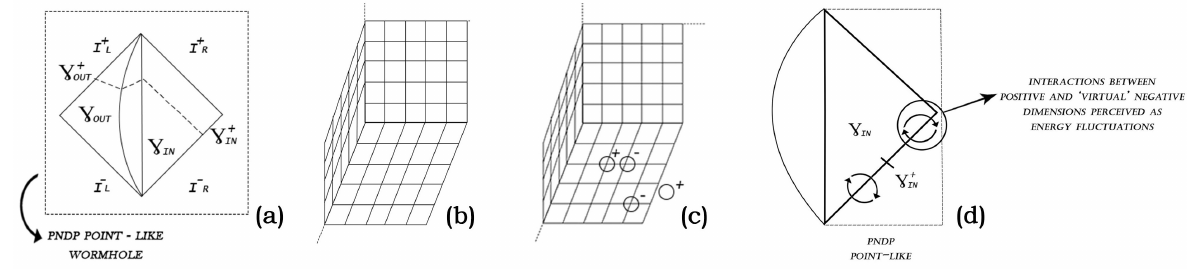
Figure 3. In ( a ), it was represented the ( 1 + 1 ) wormhole introduced and studied in Reference [27], in which we consider it created by a PNDP in a point-like version. The curve γ IN represents the entrance, while the curve γ OUT represents the exit. In ( b ), a vacuum place in space-time is represented. In ( c ), pairs of virtual particles are represented, particle-anti particle that annihilate. So, ( b , c ) represent the phenomenon known as quantum fluctuation, i.e., fluctuations in the energy of the vacuum that suddenly generate particle-antiparticle pairs that annihilate. Here, we assume that this could be generated by ( a ), i.e., the interactions between the dimensions that generate the wormhole point like, are perceived, in the entry and exit areas, as virtual energy fluctuations, as in ( d